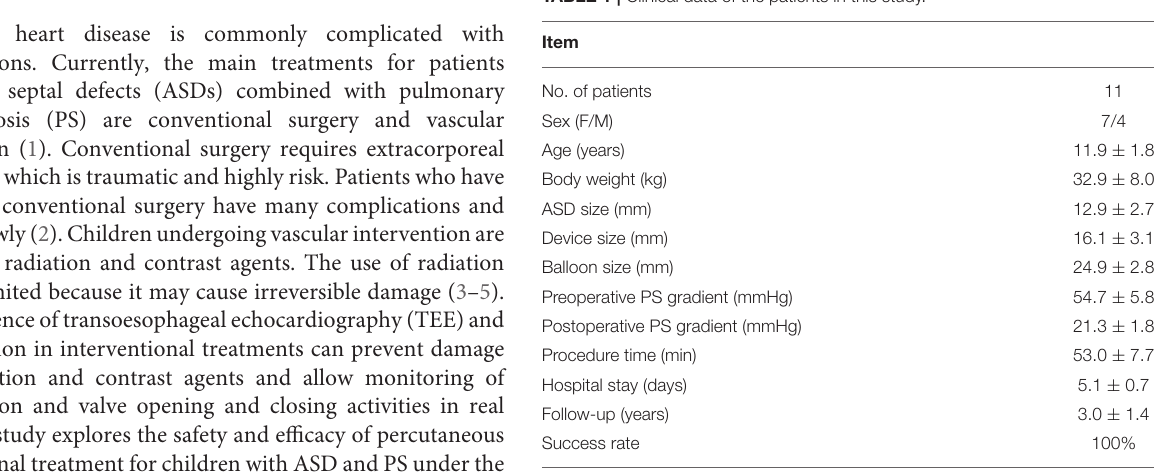
TABLE 1 | Clinical data of the patients in this